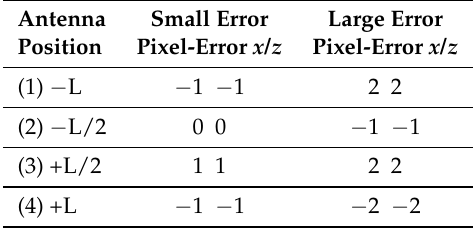
Table 3. Pixel-error introduced in different image resolutions. The results are illustrated in Figure 12.